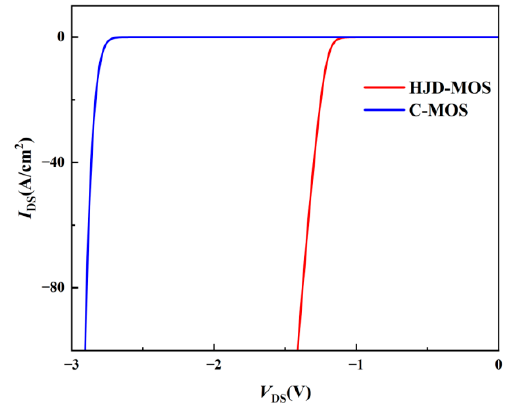
Figure 6. The reverse characters of the C-MOS and the proposed structure.